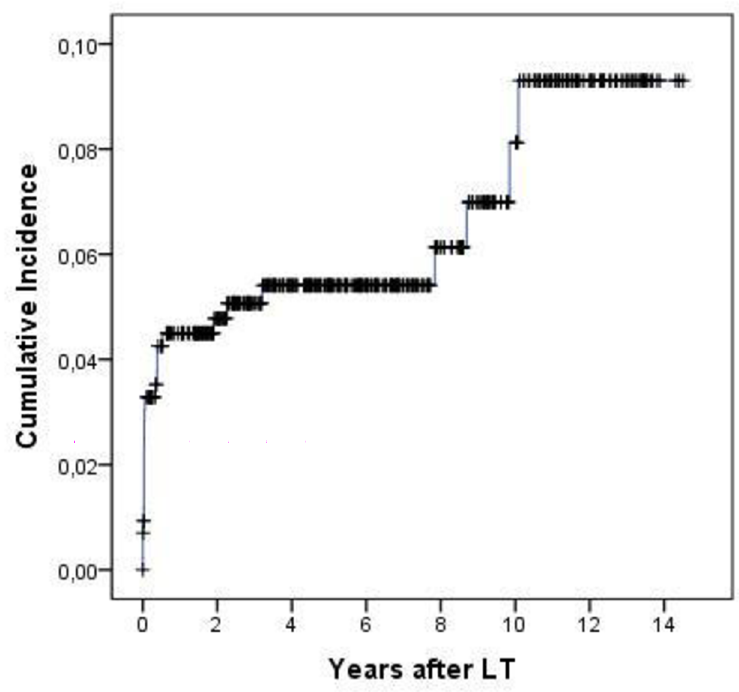
Fig 2. Kaplan Meier curve for cumulative incidence of thrombosis after liver transplantation.